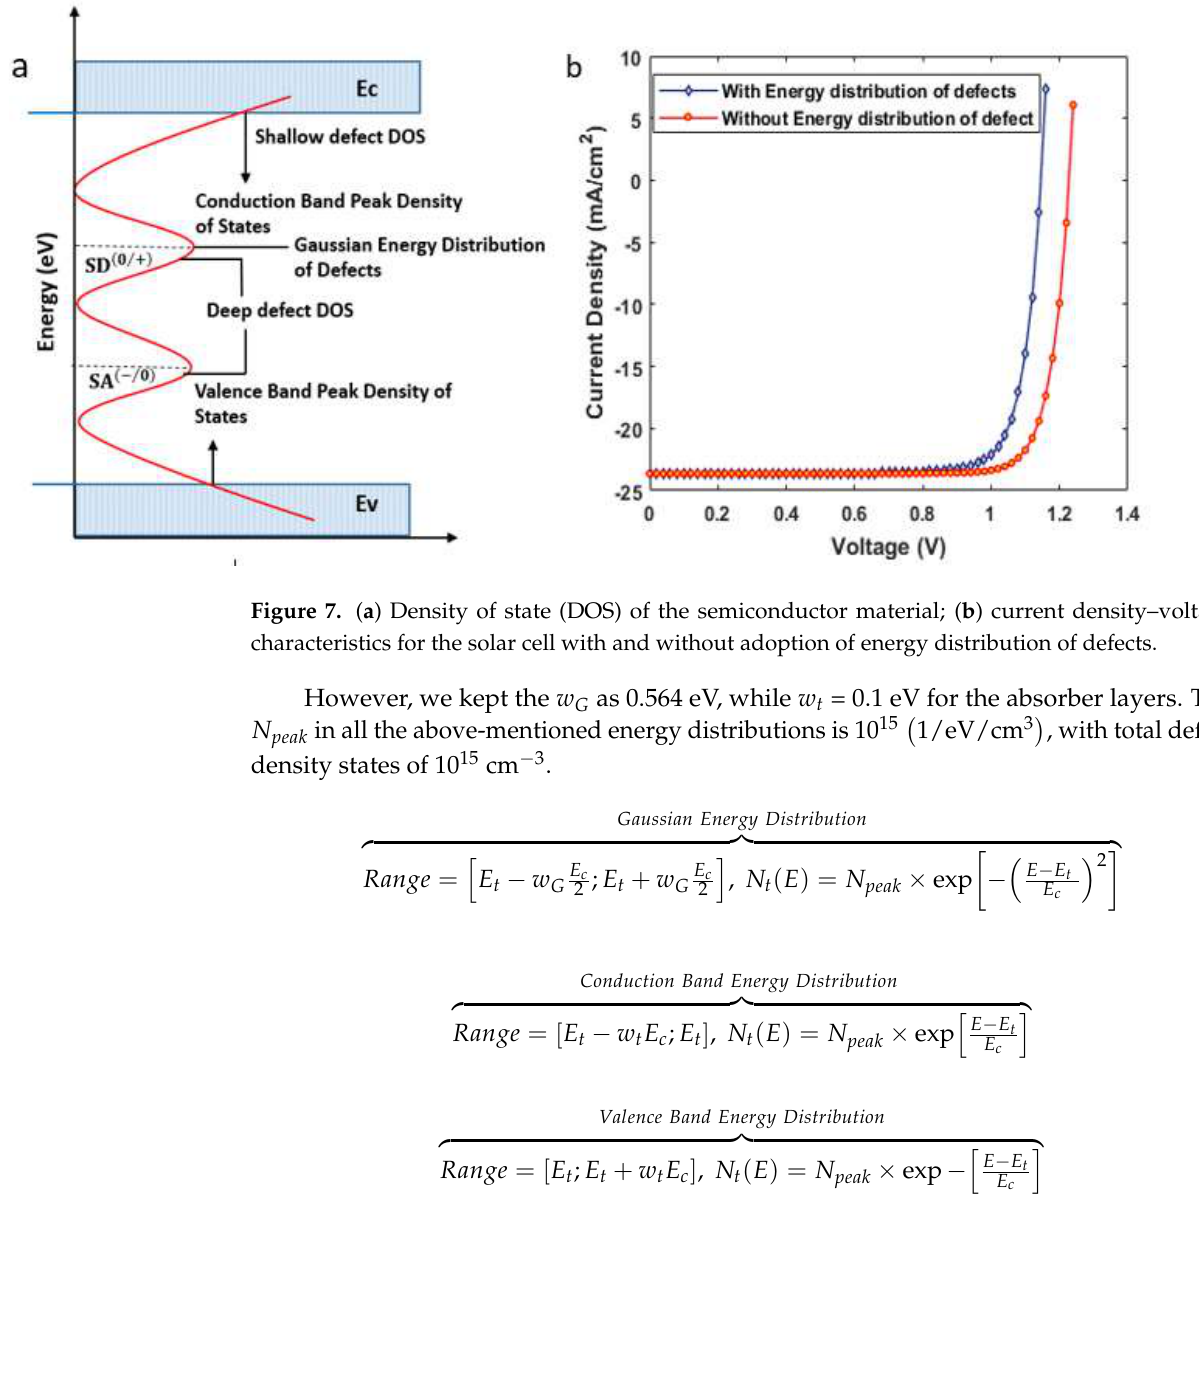
Table 2. Defect state effect on output characteristics of solar cell at trap density of 10 (cid:2869)(cid:2875) cm (cid:2879)(cid:2871) .